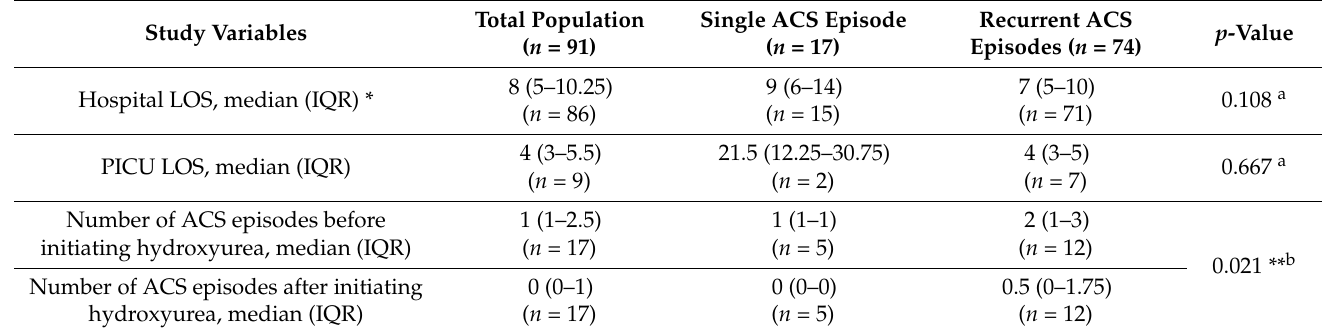
Table 4. Clinical outcomes of ACS